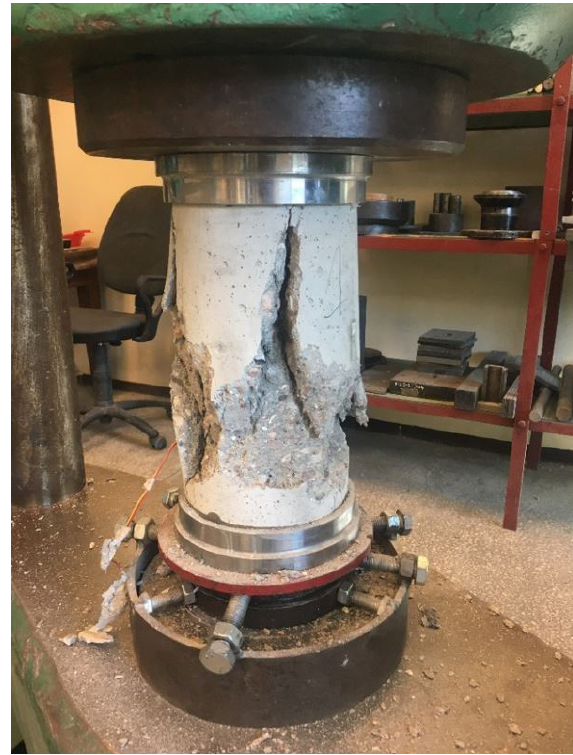
of concrete according to method II. C,S